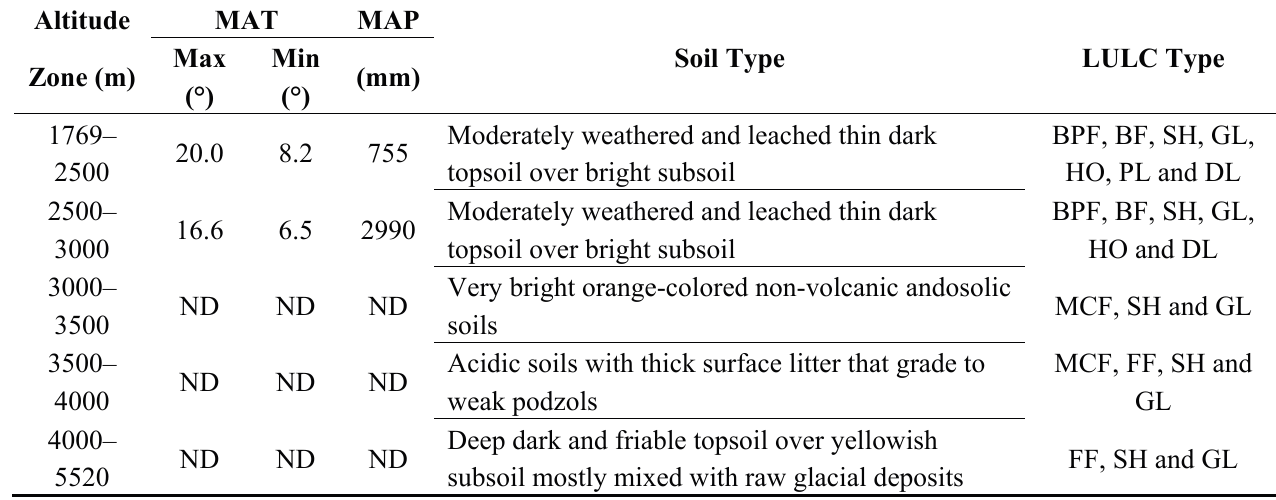
Table 1. Study site information under different altitudinal zones.